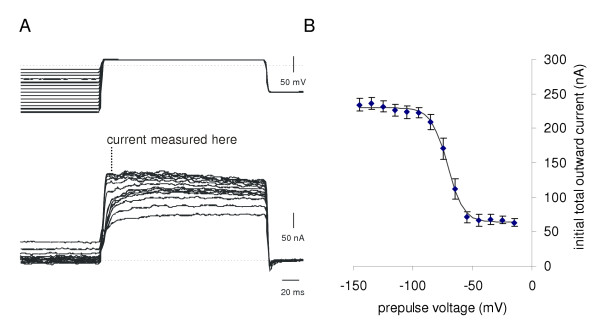
Inactivation of the transient outward current in the B1 motoneuron. A. Holding the voltage for 800 ms at different values, and stepping to a fixed potential of +15 mV, determines the inactivation of the transient outward current. The transient outward current was measured at its peak value. B. Summary data for 11 runs from 4 preparations, showing mean ± SE total outward current. The solid line shows a fit of the Boltzmann equation          to the mean data, with a half voltage (h) of -71 mV and slope (s) of -6.6 mV.